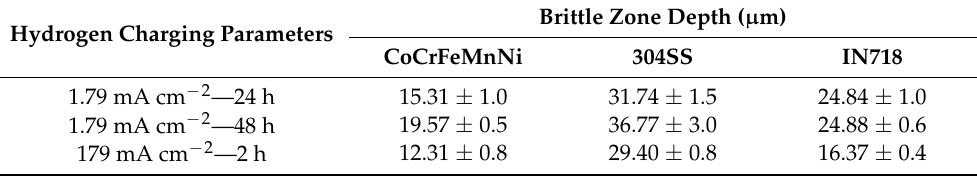
Table 4. Brittle zone area fraction of hydrogen-charged CoCrFeMnNi, 304 SS and IN718 alloy. Table 3. Brittle zone depth of hydrogen-charged CoCrFeMnNi, 304SS and IN718 alloy. Hydrogen Charging